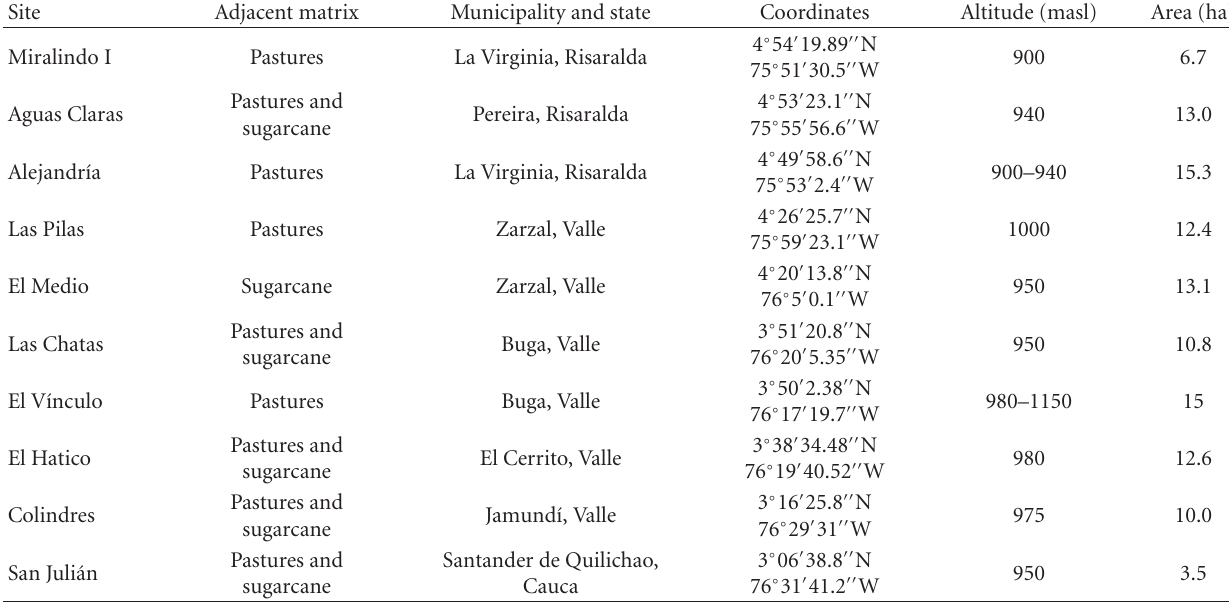
Table 1: Description of the location and characteristics of the sites within fragments of tropical dry forest in the upper watershed of the Cauca River; sites ordered geographically from North to